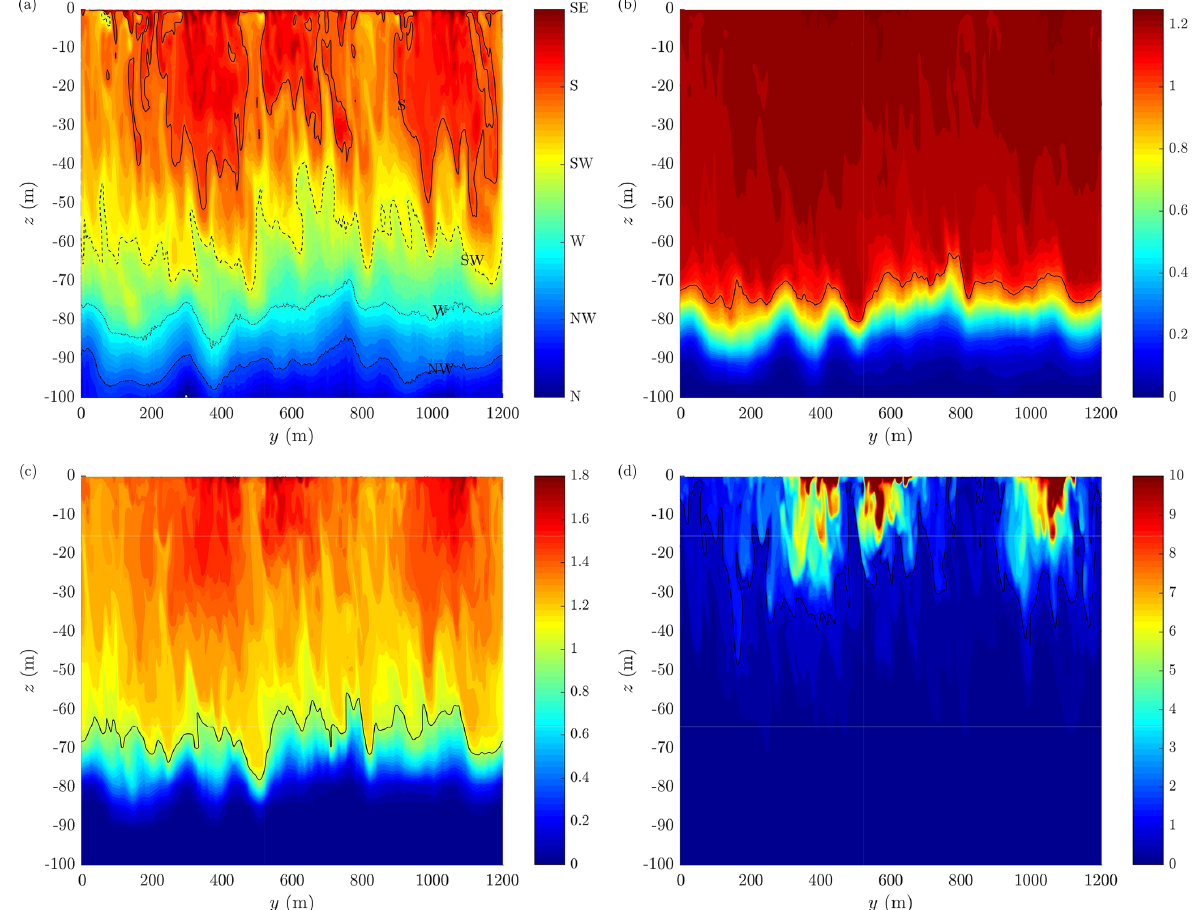
Figure 11. Direction of the horizontal flow (a) and frazil volume fraction c i / ˜ c i (b–d) along a cross section through the model domain perpendicular to the wind/wave direction ( x = 600m in Fig. 12). In (a) , a “to” convention is used, i.e., S means the current flowing to the south and so on. In (b–d) , black contours show the value of 1. Results of simulations with U a = 30ms − 1 and T a = − 20 ◦ C for series F all . See Fig. S16 for analogous plots from series F 0